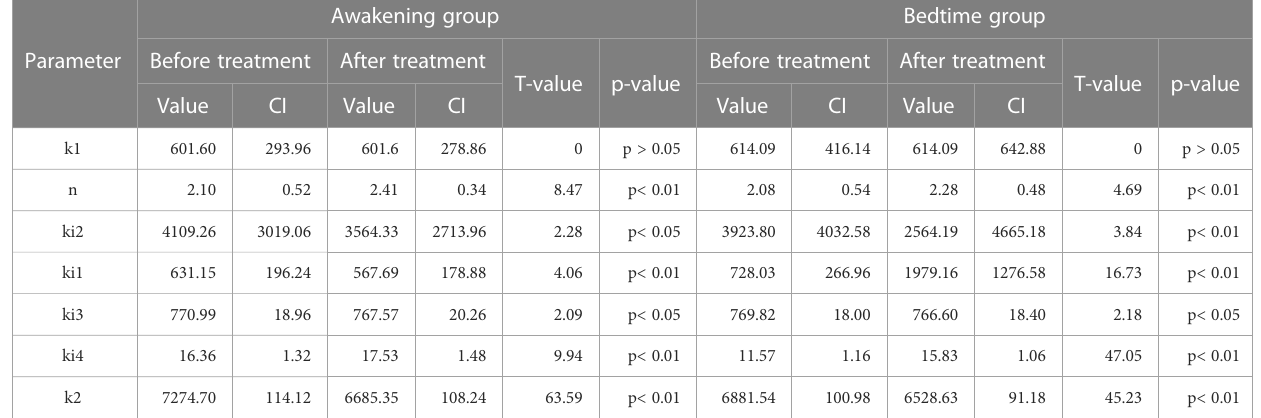
TABLE 1 Estimated parameters for awakening and bedtime administration of